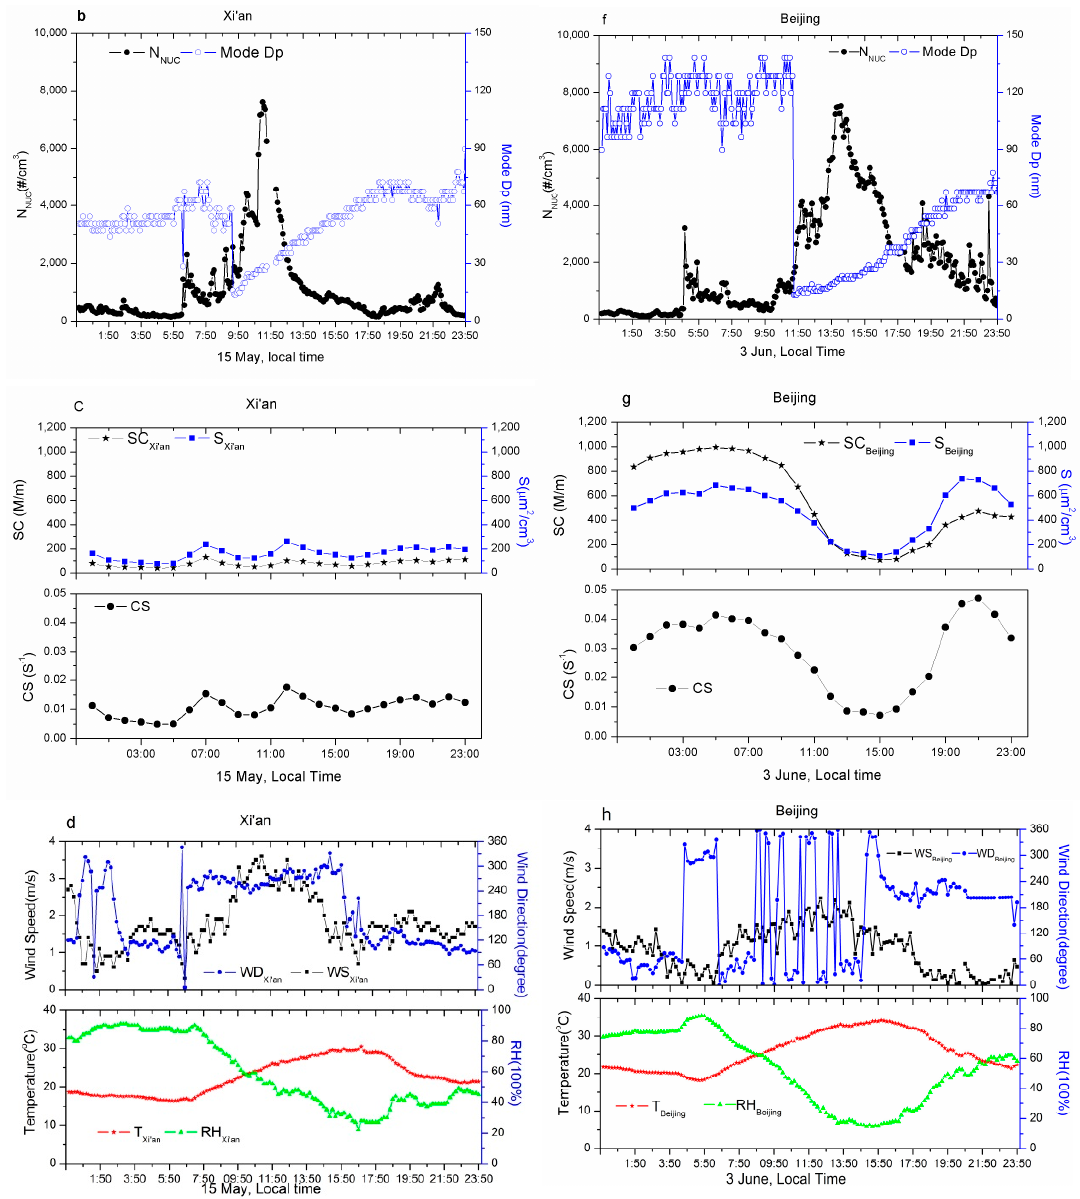
Figure 5. N NUC-Xi’an , Mode D p , Surface area concentration (S), Scattering Coefficient (SC) and Condensation Sink (CS) and surface meteorological elements (wind speed, wind direction,